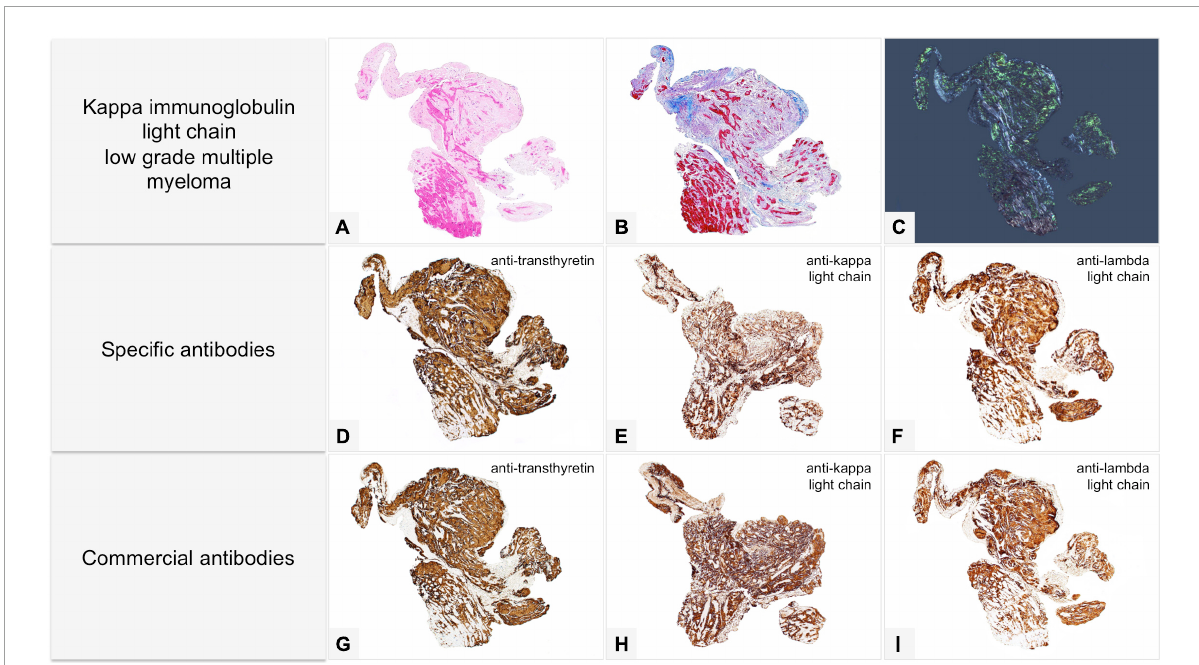
FIGURE6 Male of 81 years affected by kappa light chain low grade multiple myeloma, with score 2 cardiac uptake on scintigraphy with bone tracers. Endomyocardial biopsy was performed for suspected cardiac amyloidosis and showed slight to moderate myocardial interstitial and subendocardial amyloid deposits. Proteomic analysis with mass spectrometry in tandem mode was positive for TTR proteotypic peptides. IHC failed to type amyloid with both commercial and specific antibodies. Immunolabeling was strong and diffuse with all antibodies with no significant differences in intensity and distribution. (A–C) Histology of a biopsy fragment showing subendocardial and myocardial eosinophilic amorphous deposits with Hematoxylin-Eosin ( A: 50 × ), bluish-gray deposits with Azan Mallory trichrome ( B: 50 × ) and green birefringent deposits with Congo red under polarized light ( C: 50 × ). Specific antibodies (amY-kit reduced PeloBiotech). (D) Anti-ATTR-TIE (50 × ). (E) Anti-kappa-KRA/KUN (50 × ). (F) Anti-lambda-UTI/LAT (50 × ). Commercial antibodies against native proteins. (G) Anti-ATTR AbCam, clone EP2929Y (50 × ). (H) Anti-kappa Roche-Ventana (50 × ). (I) Anti-lambda Roche-Ventana (50 ×